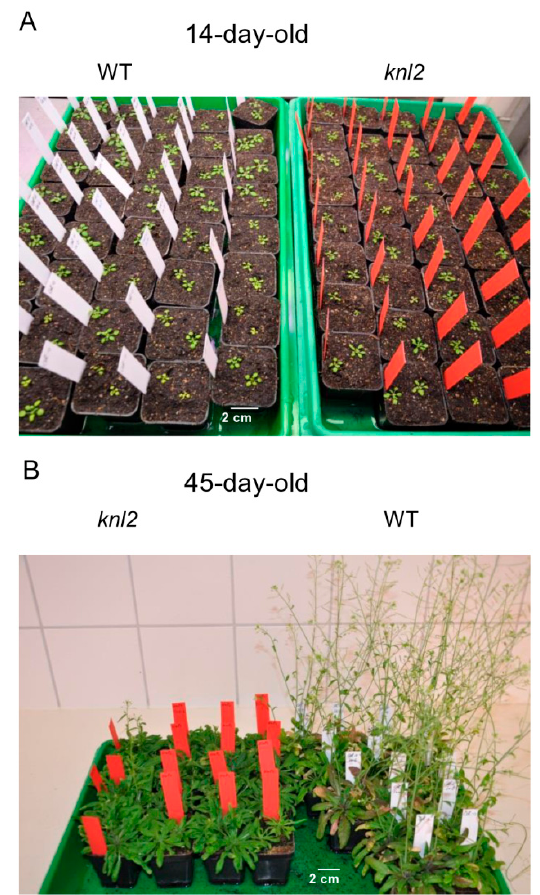
Figure 6. Effect of KNL2 depletion on the flowering time. ( A ) At early growth stages, no obvious phenotypical differences between wild-type (WT) and the knl2 mutant were observed. ( B ) The flowering time of the knl2 mutant delayed by 10–14 days compared to Arabidopsis wild-type. Seeds of the knl2 mutant and wild-type were germinated under short-day conditions, 8 h light/20° C and 16 h dark/18 °C, for two weeks and then plants were transferred to the cultivation room with long-day conditions, 16 h light/20 °C and 8 h dark/18 °C.